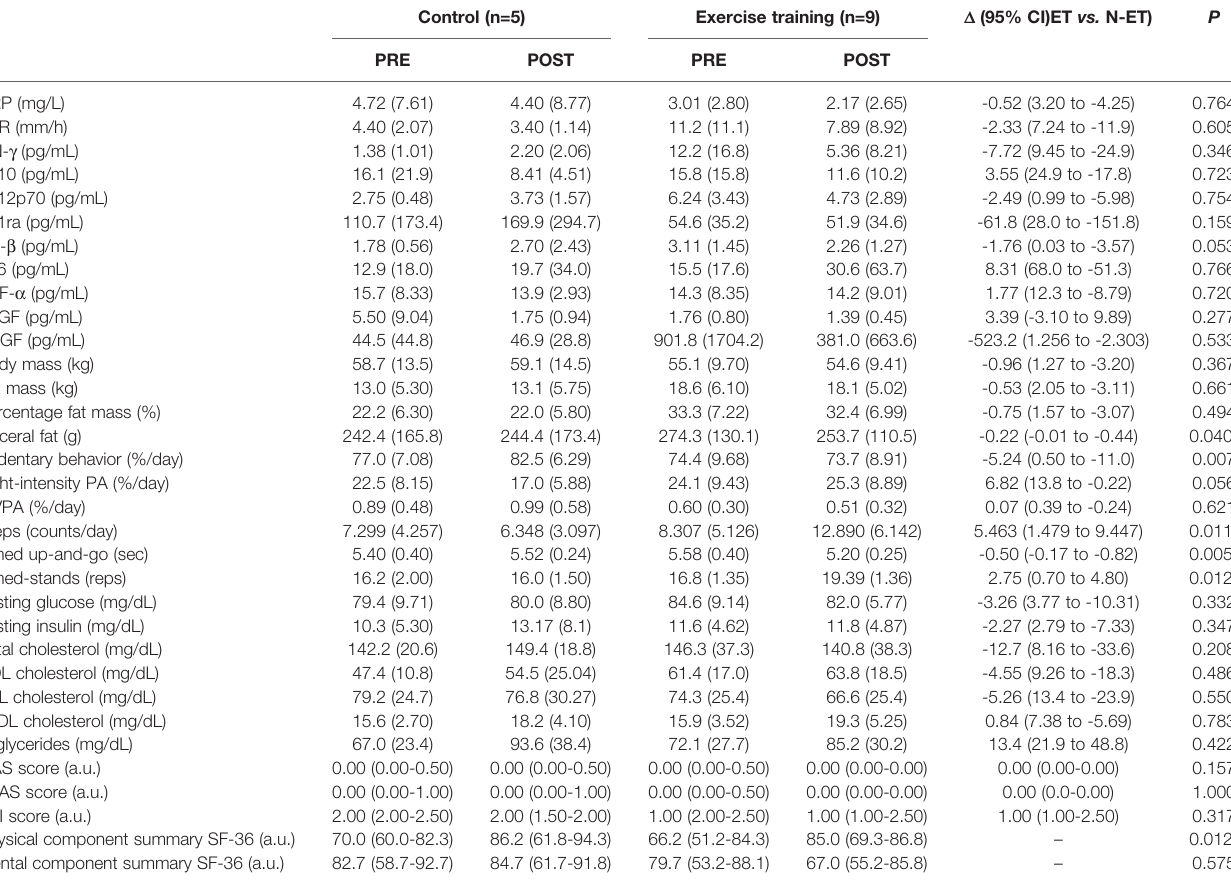
TABLE 2 | Effects of a 12-week, home-based, exercise training program on systemic in fl ammation, body composition, physical activity levels, functionality, aerobic capacity, cardiometabolic risk factors, disease and health-related quality of life parameters in childhood-onset Takayasu Arteritis patients. Control